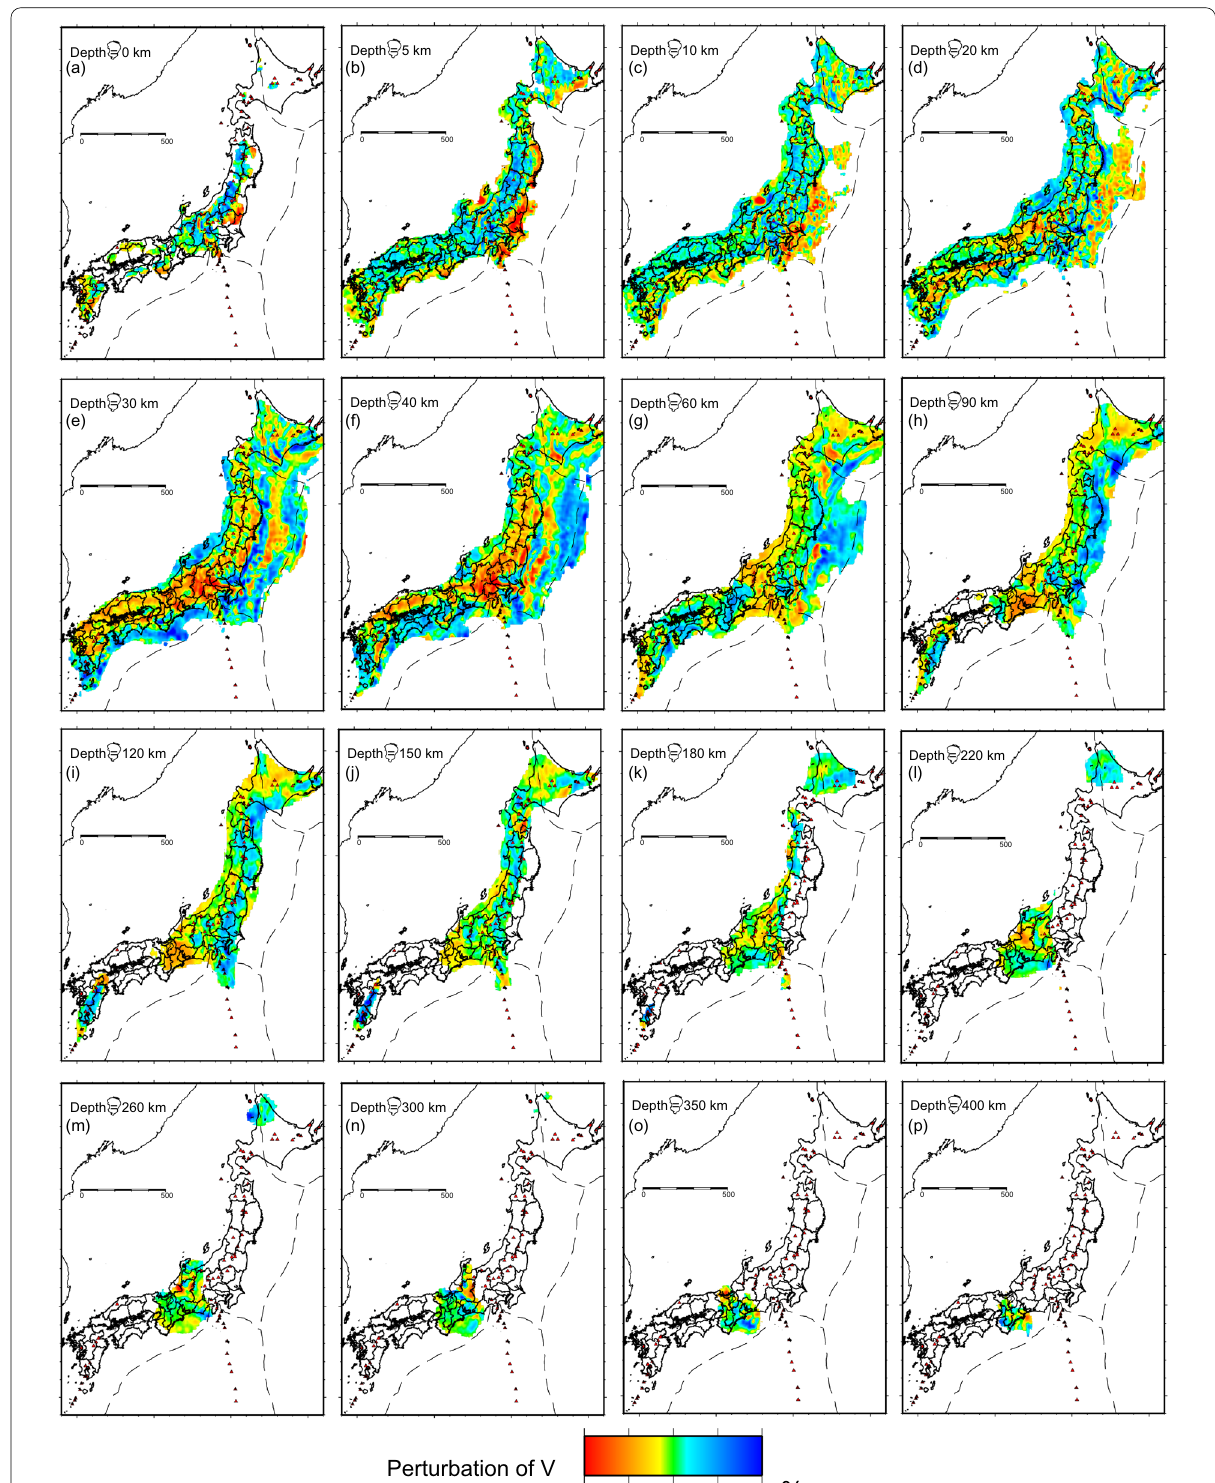
Fig. 10 Map views of Vp perturbation beneath Japanese